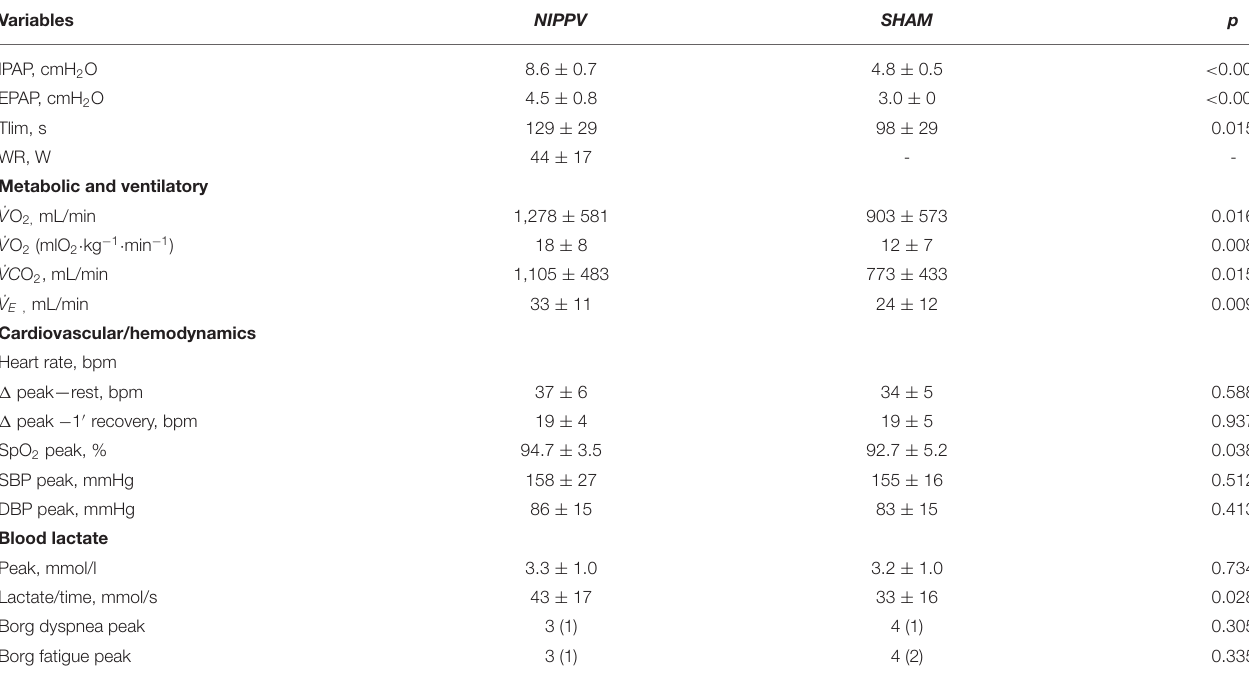
TABLE 1 | Effects of non-invasive positive pressure ventilation (NIPPV) and SHAM ventilation on selected metabolic, ventilatory, and cardiovascular/hemodynamics at exercise cessation [peak of constant load exercise (CLE)] ( N = 14). Variables NIPPV